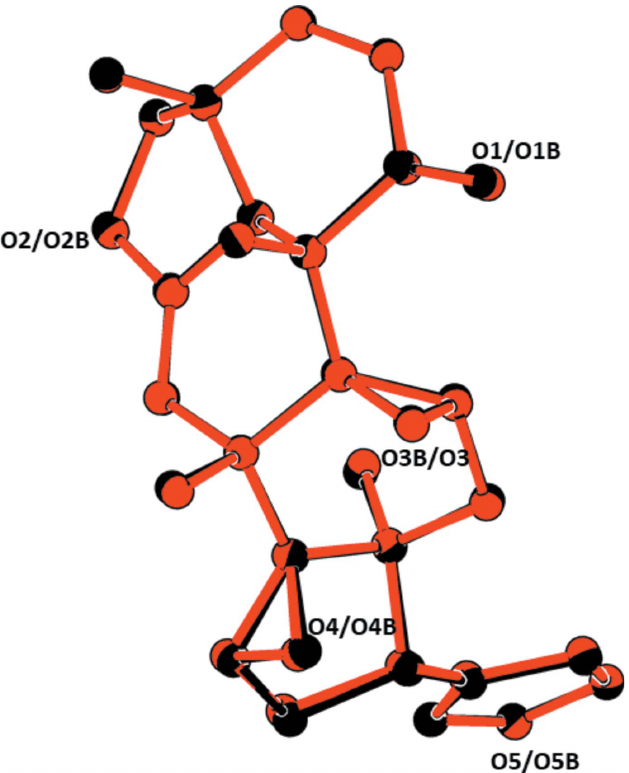
Figure 2 A view of the AutoMolFit ( PLATON ; Spek, 2009) of the two independent molecules of TS3 (colour code: black = molecule 1, red = molecule 2).